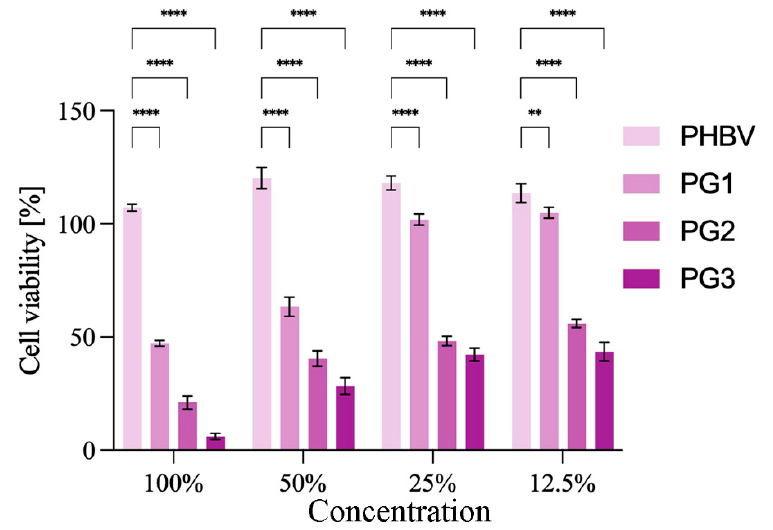
Figure 7. Anticancer studies: cytotoxicity of the obtained films towards HCT116 (colon cancer) cells are presented as a function of biomaterial composition (PG content) and biomaterial extract dilution. Significant differences compared to the control, neat biopolymer sample, for the same dilution are indicated by an asterisk (** p ≤ 0.01, **** p ≤ 0.0001).